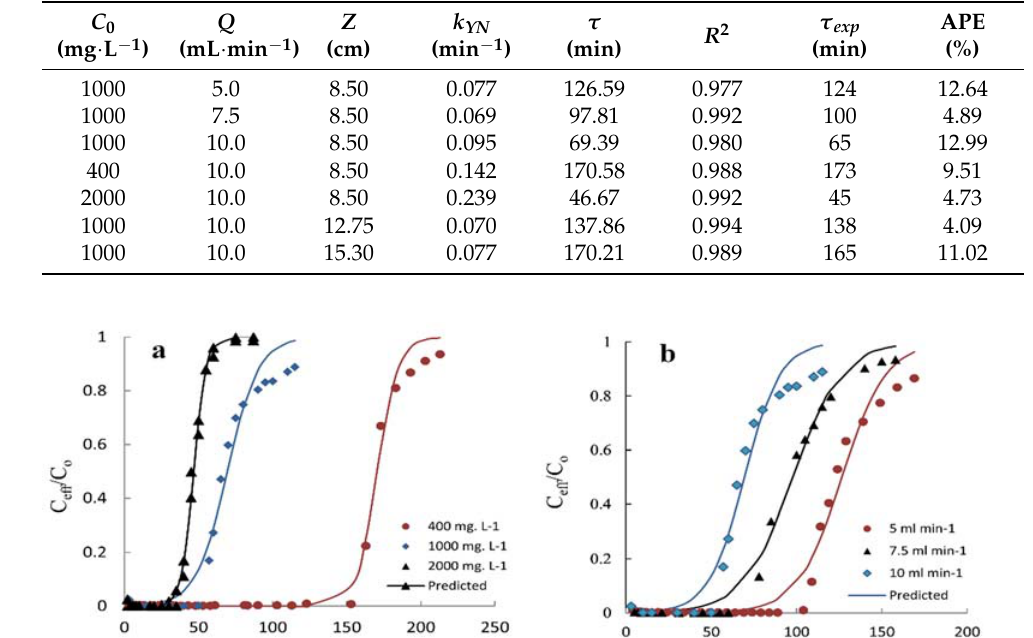
Table 3. The Yoon–Nelson model parameters at dissimilar conditions.